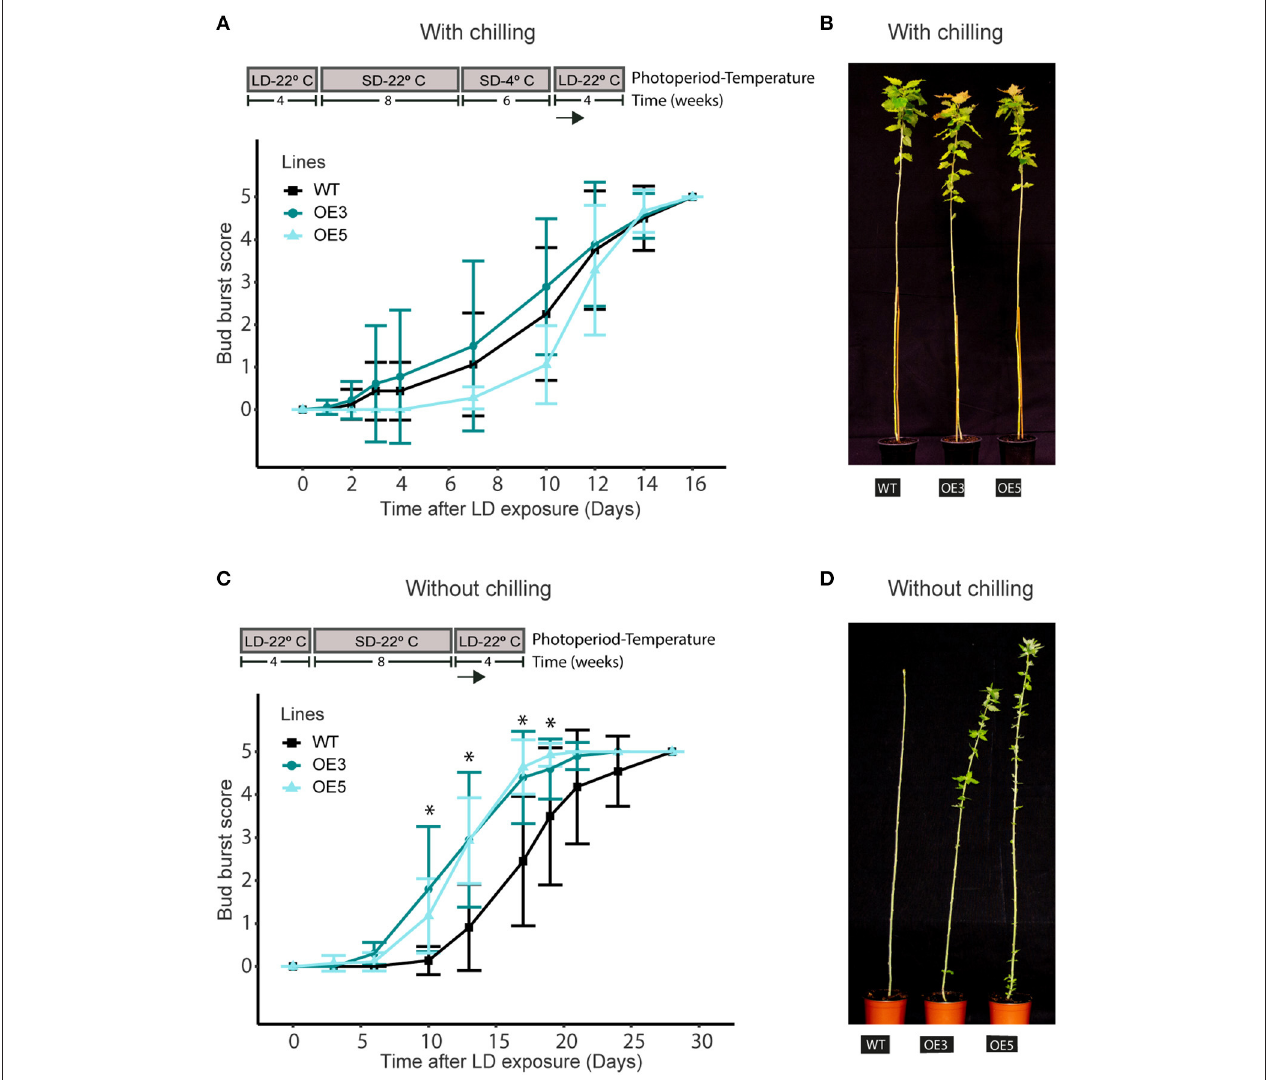
FIGURE 3 | MADS12 overexpression promotes early bud break of ecodormant poplars. Bud break scoring of hybrid poplar MADS12 overexpressing OE3 and OE5 lines and wild type after transferring to LD and 22 ◦ C conditions (A,B) with chilling treatment and (C,D) without chilling treatment. (B,D) Representative picture of bud break differences in (B) plants after 15 days of LD exposure and (D) plants after 10 days of LD exposure. Values represent the mean of the bud score measure of n = 10–15 plants. Significant differences between overexpressing (OE) and wild type (WT) were analyzed using Tukey test, * p < 0.05. Top panels indicate photoperiodic and temperature conditions